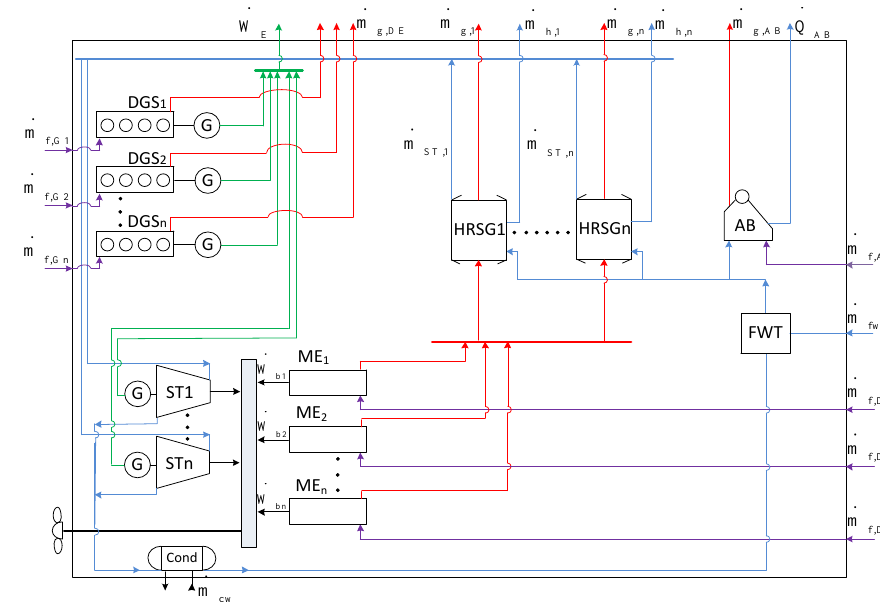
Figure 8. Superconfiguration of the generic energy system. (AB: auxiliary boiler; Cond: condenser; DGS: Diesel generator set; FWT: feed water tank, G: generator; HRSG: heat recovery steam generator; ME: main engine, ST: steam turbine).